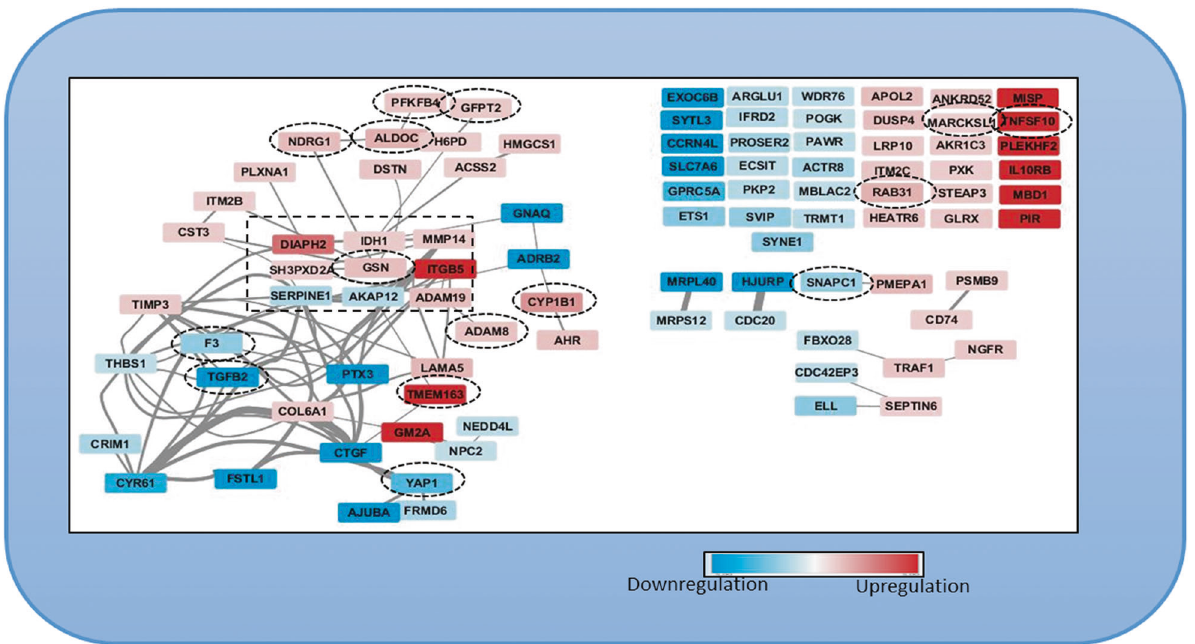
Fig. 7 Network of 94 invadopodia-speci fi c proteins resulting from the protein pro fi ling analysis after co-knockdown of YAP + TAZ in MDA-MB-231 cell line. Invadopodia-speci fi c proteins that were upregulated (red) and downregulated proteins (blue) are shown. Sixty-three proteins had either functional or physical protein associations whereas 38 proteins did not have a known protein association. Proteins differentially expressed in both proteomics and transcriptomic pro fi ling are encircled in black dotted